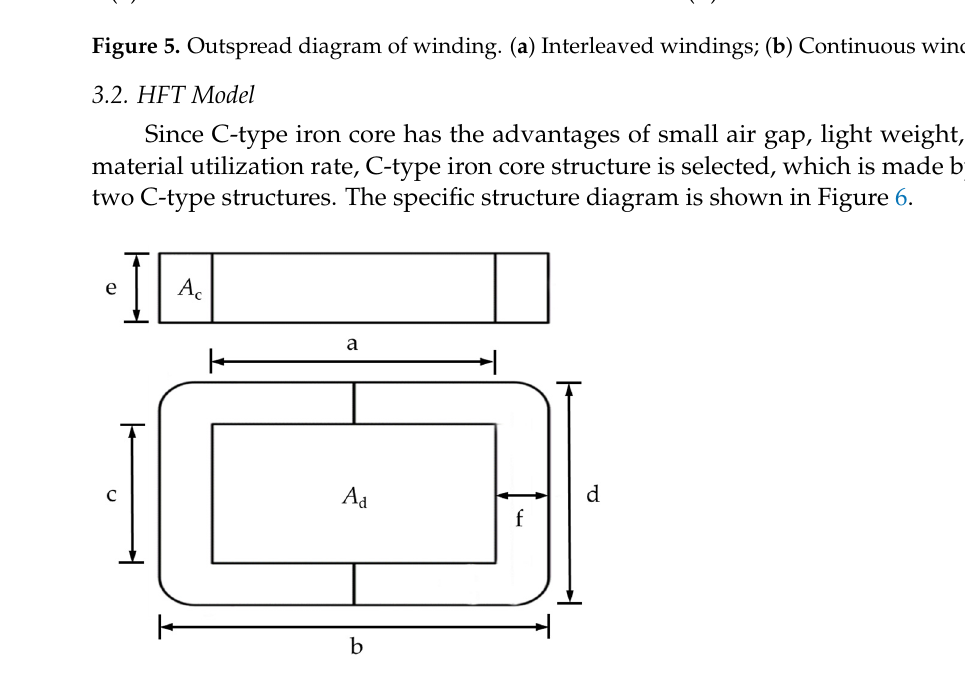
Figure 6. Schematic diagram of C-core, where, “a” and “c” are the length and height of iron core window, respectively. “b”, “e” and “d” are the length, width and height of core, respectively. “f” is the width of magnetic circuit. Ac is cross-sectional area of iron core. Ad is area of iron core win- dow.